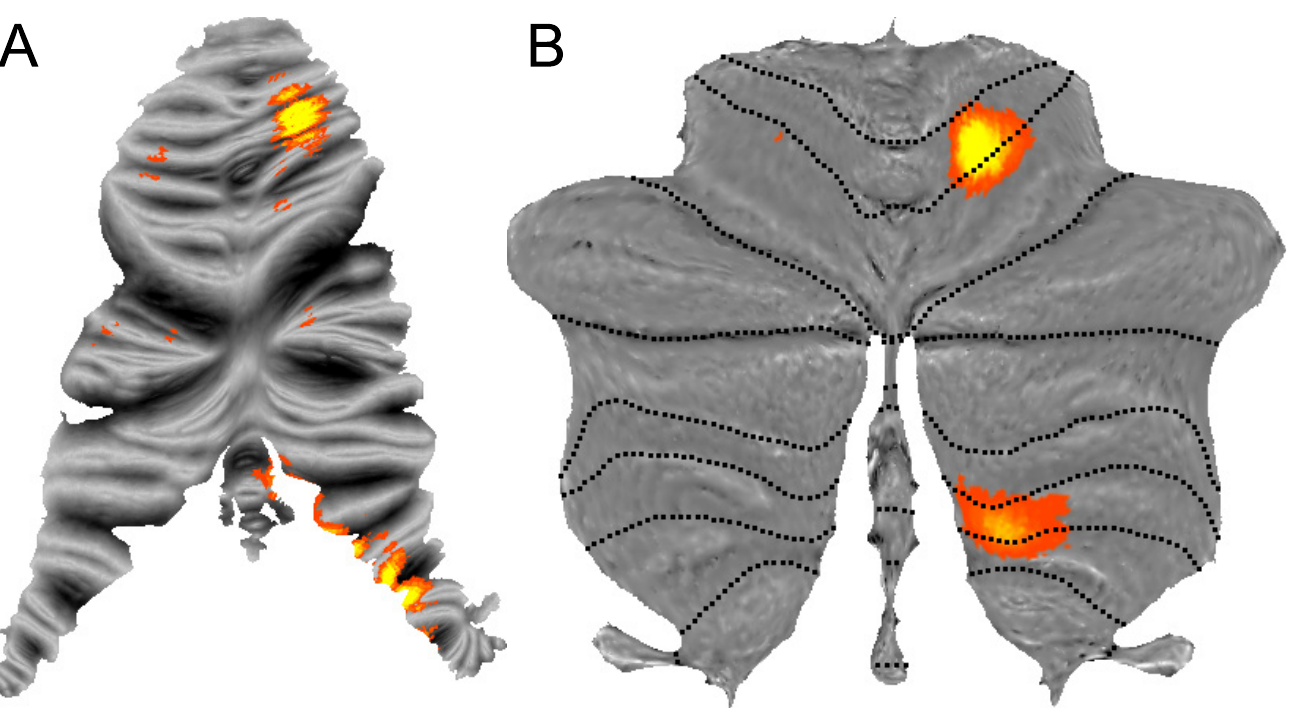
Fig 1. Representation of individual fingers in the human cerebellum. Shown is the classification accuracy with which the moved finger can be determined from the local pattern of activity, with a threshold of z > 1 [17]. ( A ) Data projected onto a surface based on a single anatomy [2] displays single closed activation clusters as a fractured series of blobs. ( B ) Projection to the new flatmap ensures that single clusters in the volume are also presented as such on the surface.